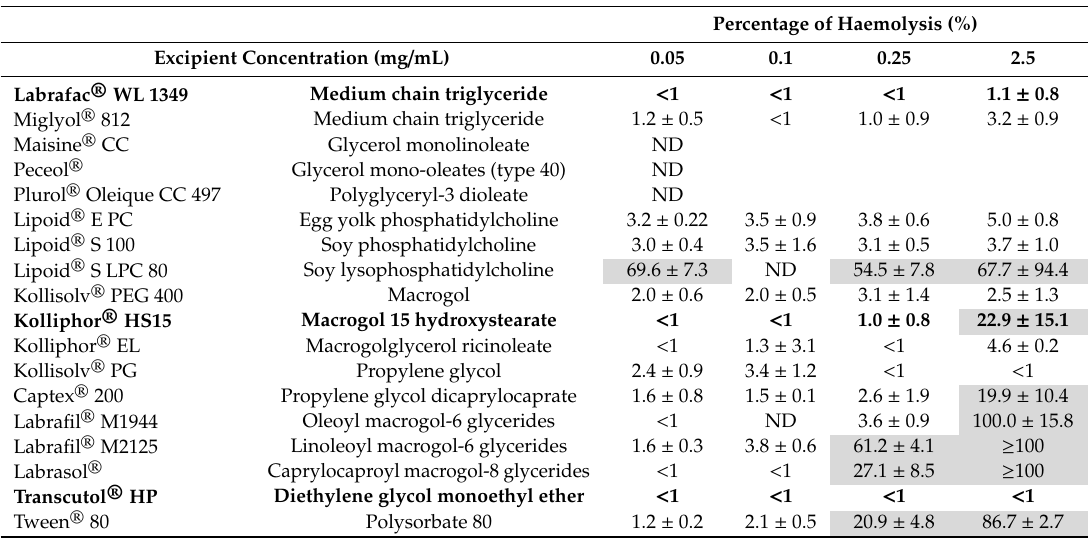
Table 3. Results of the haemolysis test performed on various excipients (ND: not determined; results above 5% of haemolysis have been greyed